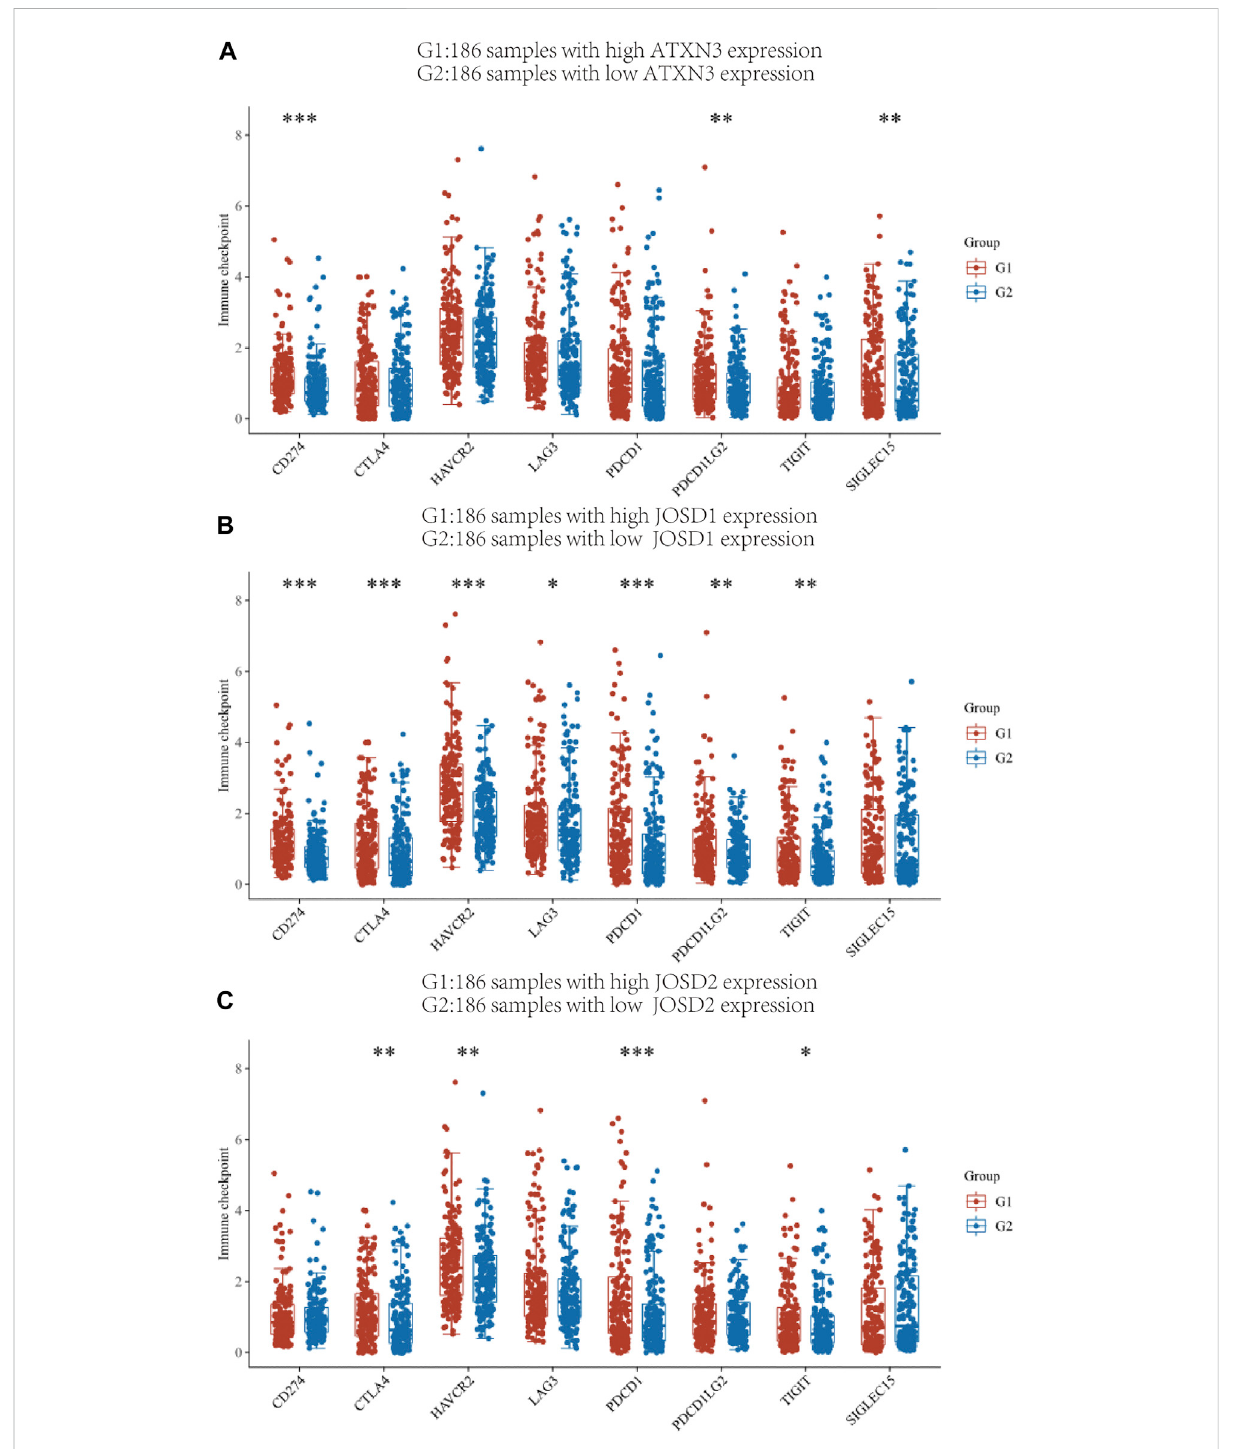
FIGURE 10 The relationship between MJDs gene expression and immune checkpoints (A-C) The HCC patients in the TCGA database were classi fi ed into high expression group (G1) and low expression group (G2) based on the various levels of ATXN3, JOSD1 and JOSD2 gene expression, and the associationbetweenthetwogroupsandtheexpression ofimmunecheckpointswaspresented,respectively.* p < 0.05, ** p < 0.01,and*** p <